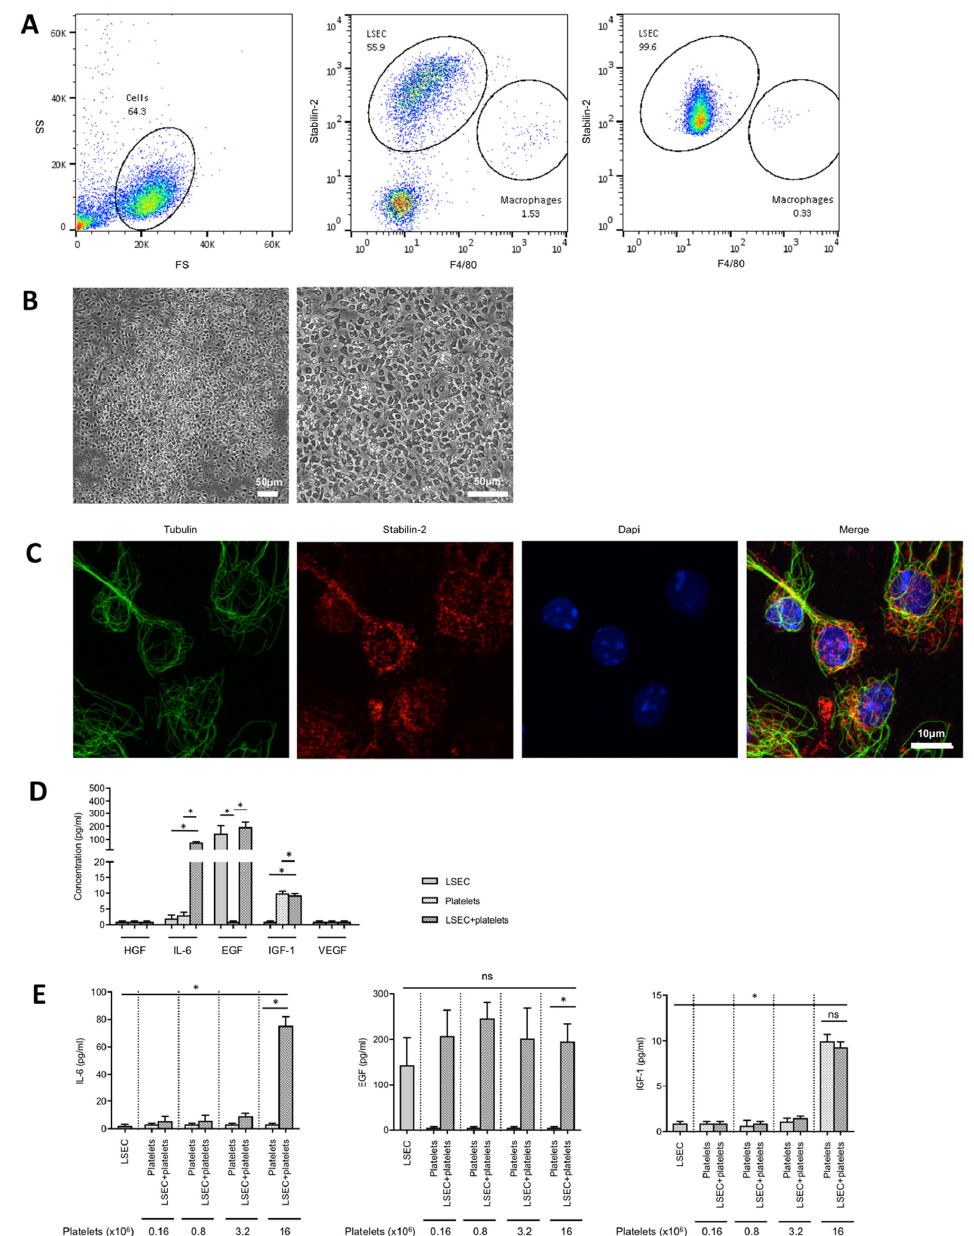
Figure 1. Platelets stimulate liver sinusoidal endothelial cells (LSECs) to release interleukin-6 (IL-6). ( A ) Dot-plots of flow cytometry analysis for CD11b-negative cells. Left panel: gating strategy. Middle panel: counting step, after CD11b-MACS but before long-term selective adherence. Right panel: purity after long-term selective adherence. LSECs were defined as stabilin-2 + F4 / 80- cells, macrophages as F4 / 80 + cells. Unstained cells were considered as unidentified. ( B ) Purified primary LSECs in culture 24 h after isolation. Left panel: magnification 100 × . Right panel: magnification 200 × . ( C ) LSECs were characterized by immunofluorescence using antibodies against stabilin-2 (red) and tubulin (green); nuclei are stained with dapi (blue). ( D ) LSECs were cultured for 24 h with or without 16 million resting platelets and release of growth factors (hepatocyte growth factor—HGF, IL-6, epidermal growth factor—EGF, insulin-like growth factor-1—IGF-1, and vascular endothelial growth factor—VEGF) was measured. ( E ) LSECs were co-cultured with di ff erent quantities of resting platelets (from 0.16 to 16 million), and releases of IL-6, EGF, and IGF-1 were measured in the culture medium. N = 4, * p <